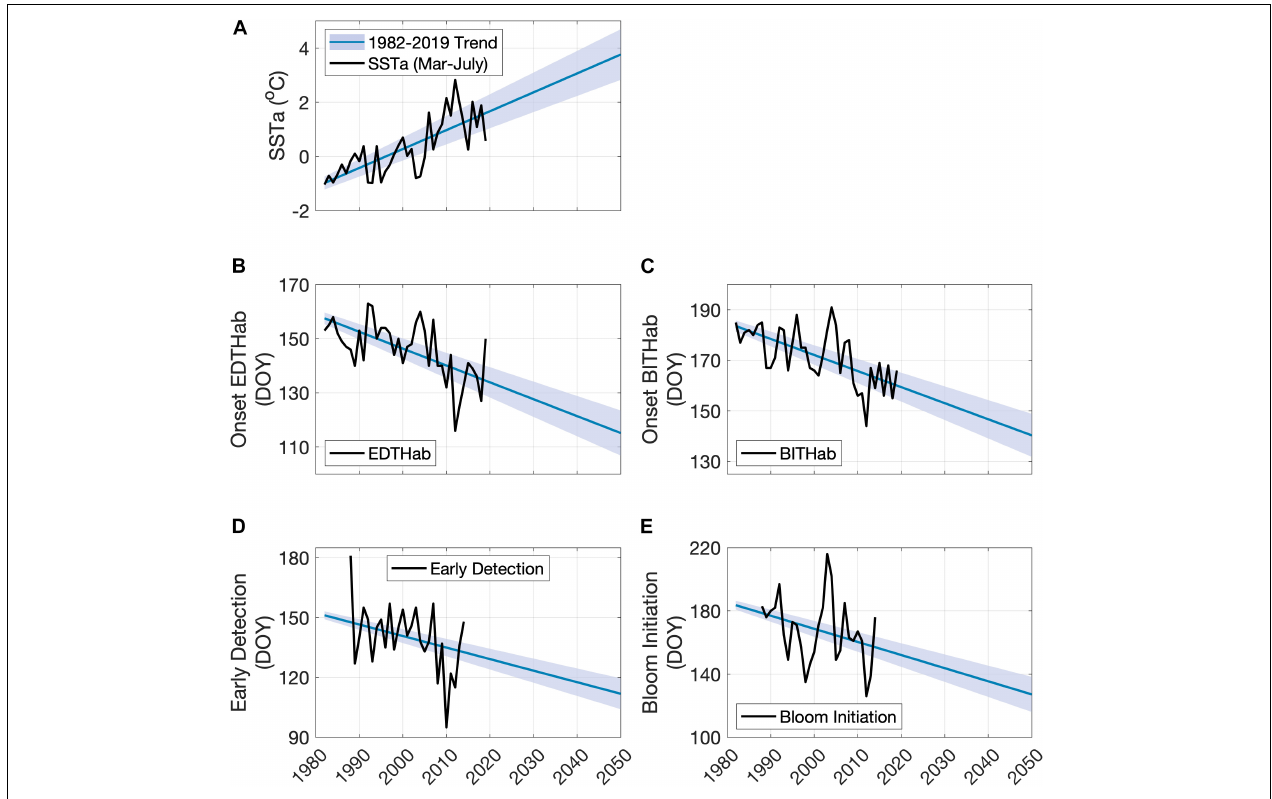
FIGURE 9 | Observed and projected SSTa Mar-Jul for the Bay of Fundy (A) , dates of EDTHab (B) and BITHab (C) , early detection (D) , and bloom initiation (E) of A. catenella in the Bay of Fundy. The black solid line in each plot corresponds to the observed data. The blue line represents the projected data using the full extent of available SSTa (1982–2019) ± 1 standard deviation (shaded blue